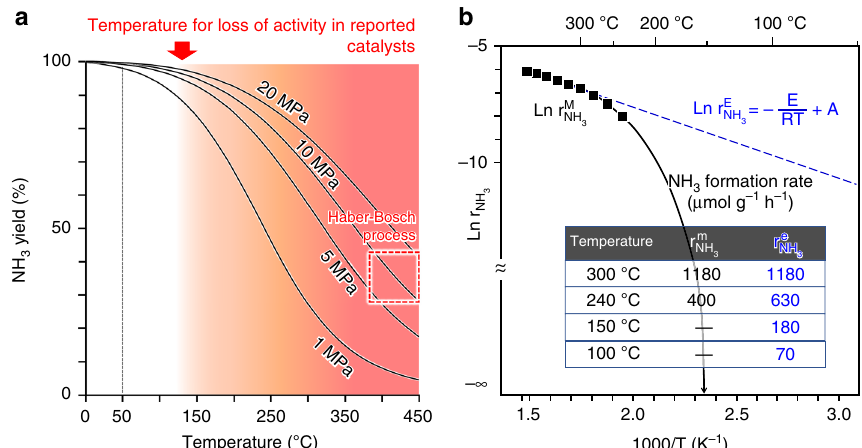
Fig. 1 Ammonia synthesis from N 2 and H 2 . a Correlation of ammonia yield with temperature and pressure. b Arrhenius plots for ammonia synthesis over a commercial Fe